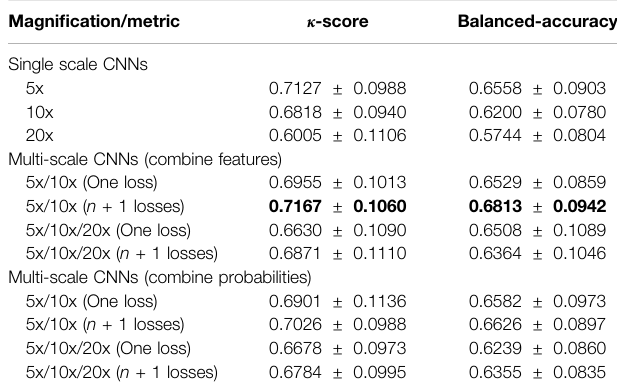
TABLE 4 | Performance of the multi-scale CNNs architectures, compared with CNNs trained with patches from only one magni fi cation level, evaluated in κ -score and balanced accuracy. Both the multi-scale architectures are presented (combine features and combine predictions from multi-scale branches) and both the training variants (one loss function and n + 1 losses). The values marked in bold highlight the method that reaches the highest performance, respect to the